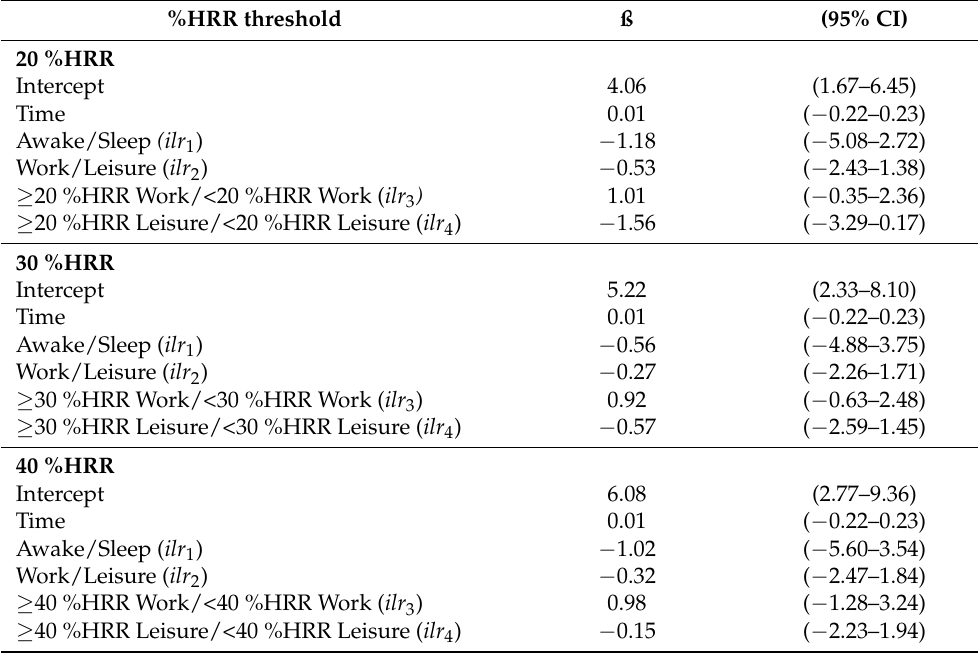
Table 3. Models describing the association between time spent above 20 %HRR, 30 %HRR, and 40 %HRR and overall musculoskeletal pain ( n =